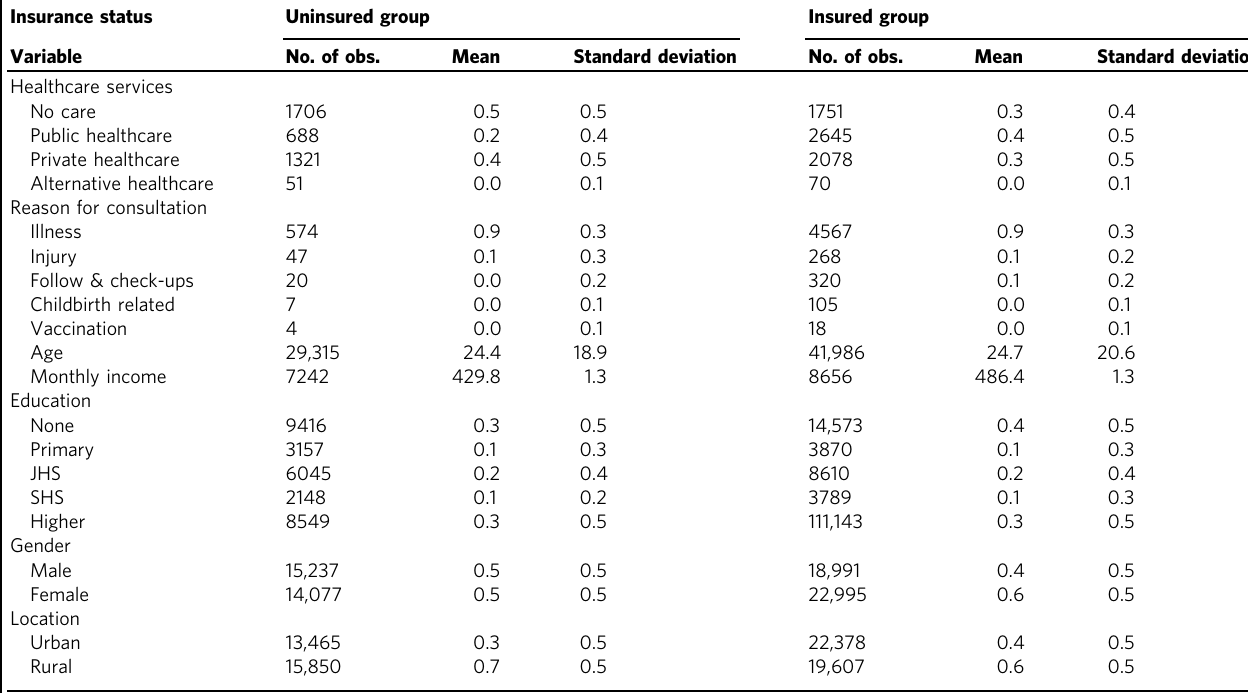
Table 3 Summary statistics of the dependent variables and background characteristics for the uninsured and insured groups.